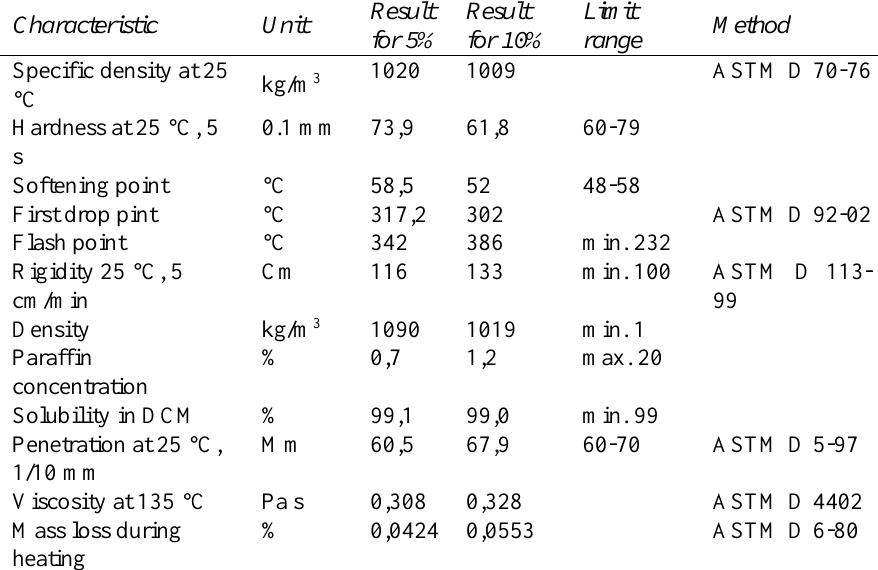
Table 4. Physicochemical and mechanical properties of bituminous material with 5